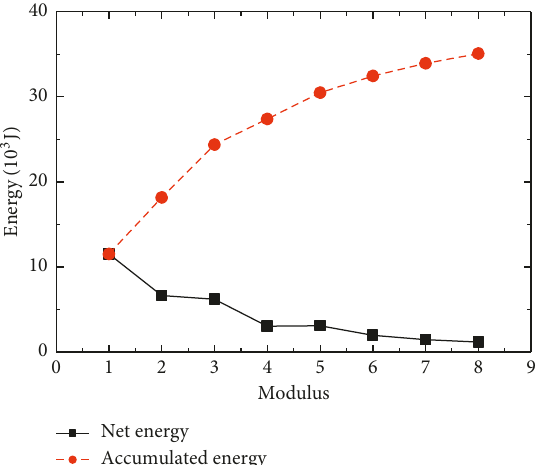
Figure 9: Net energy and accumulated energy for each mold of the shaft lining.